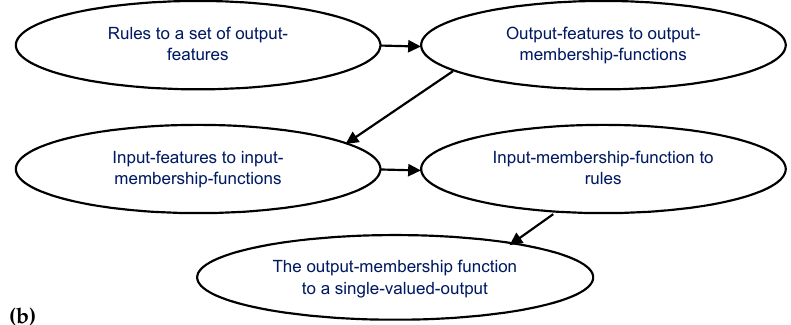
Figure 6. Modeling approach, ( a ) Flowchart representing the MLP (a feed-forward-ANN), ( b ) Five functional blocks in ANFIS.